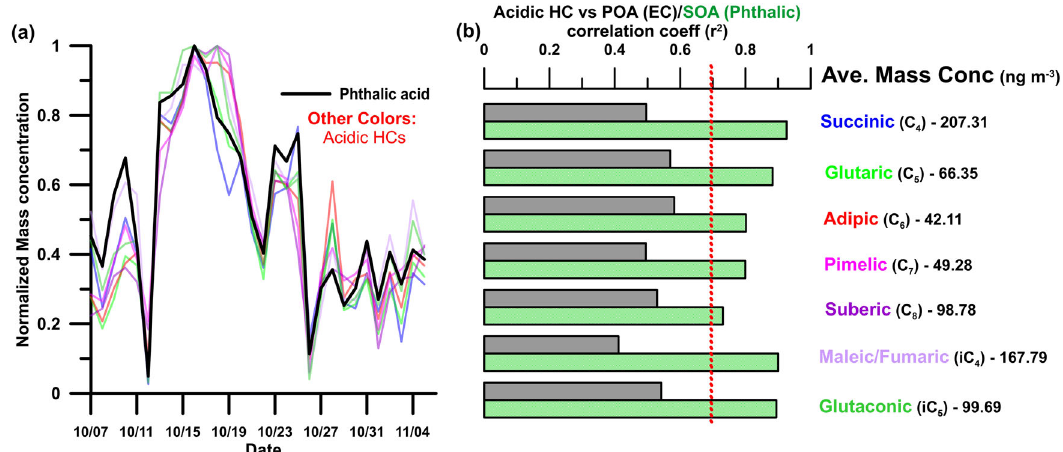
Fig. 3 Pro fi le of the urban tracers in submicron aerosols. a Time series of the normalized mass concentration of phthalic acid and other dicarboxylic acids. The black line is for the phthalic acid while the other colors are for the other urban tracers. b Production pathway analysis of urban dicarboxylic acid based on their relationship with elemental carbon and phthalic acid, which are indicators for primary and secondary origins. The numbers in the legend are the mean mass concentration of the urban